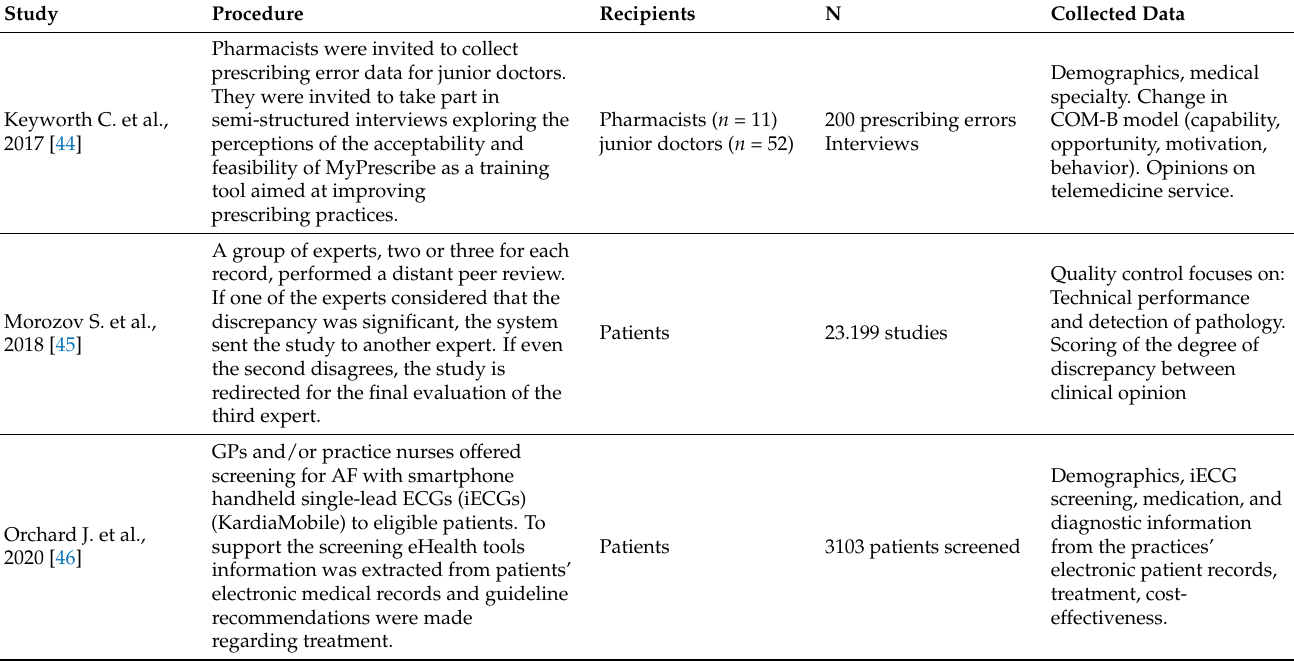
Table 4. Description of audit features included in studies where the audit or feedback was performed via a telemedicine